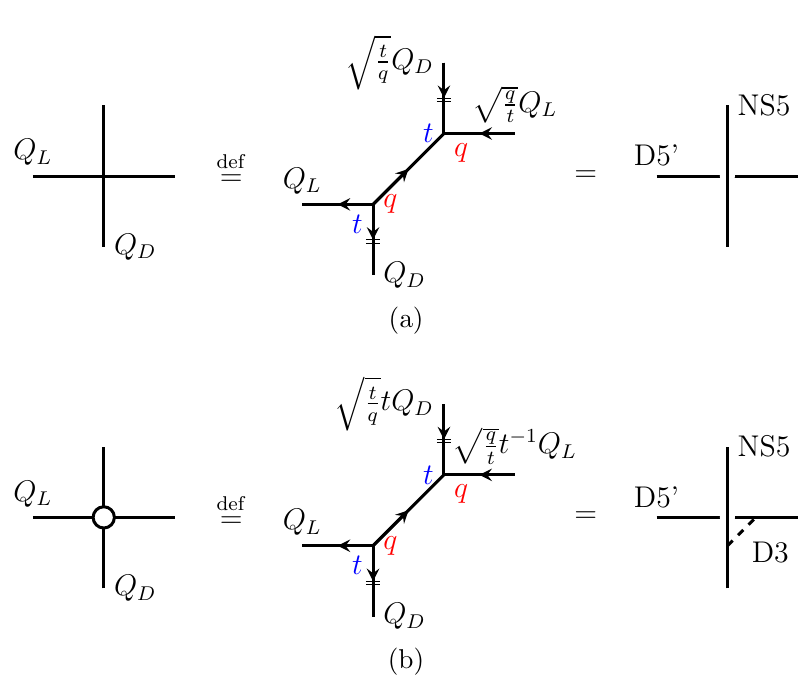
Figure 6 . Higgsing of the resolved conifold geometry leading to two di(cid:11)erent types of crossings. Notice the particular values of the K(cid:127)ahler parameters on the legs. (a) An \empty" crossing, i.e. without D3 branes stretched between the NS5 and D5’. (b) a \full" crossing, i.e. with one D3 brane stretched between the NS5 and